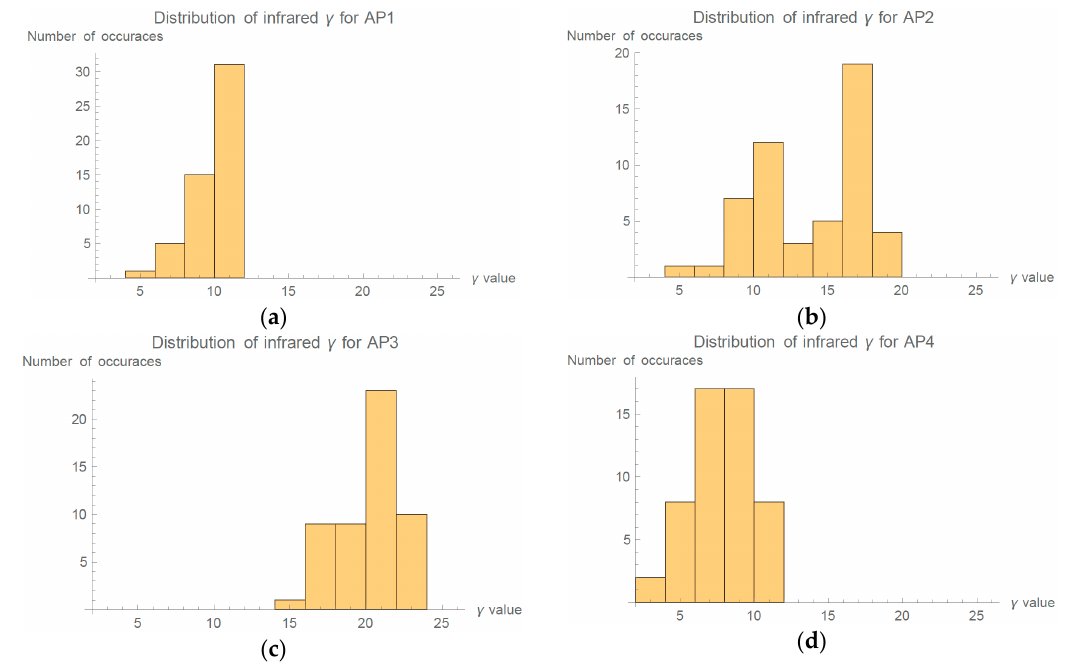
Figure 9. Histogram representing all 52 calculated γ for each AP during evaluation: ( a ) AP 1; ( b ) AP2; ( c ) AP3; and ( d ) AP4.